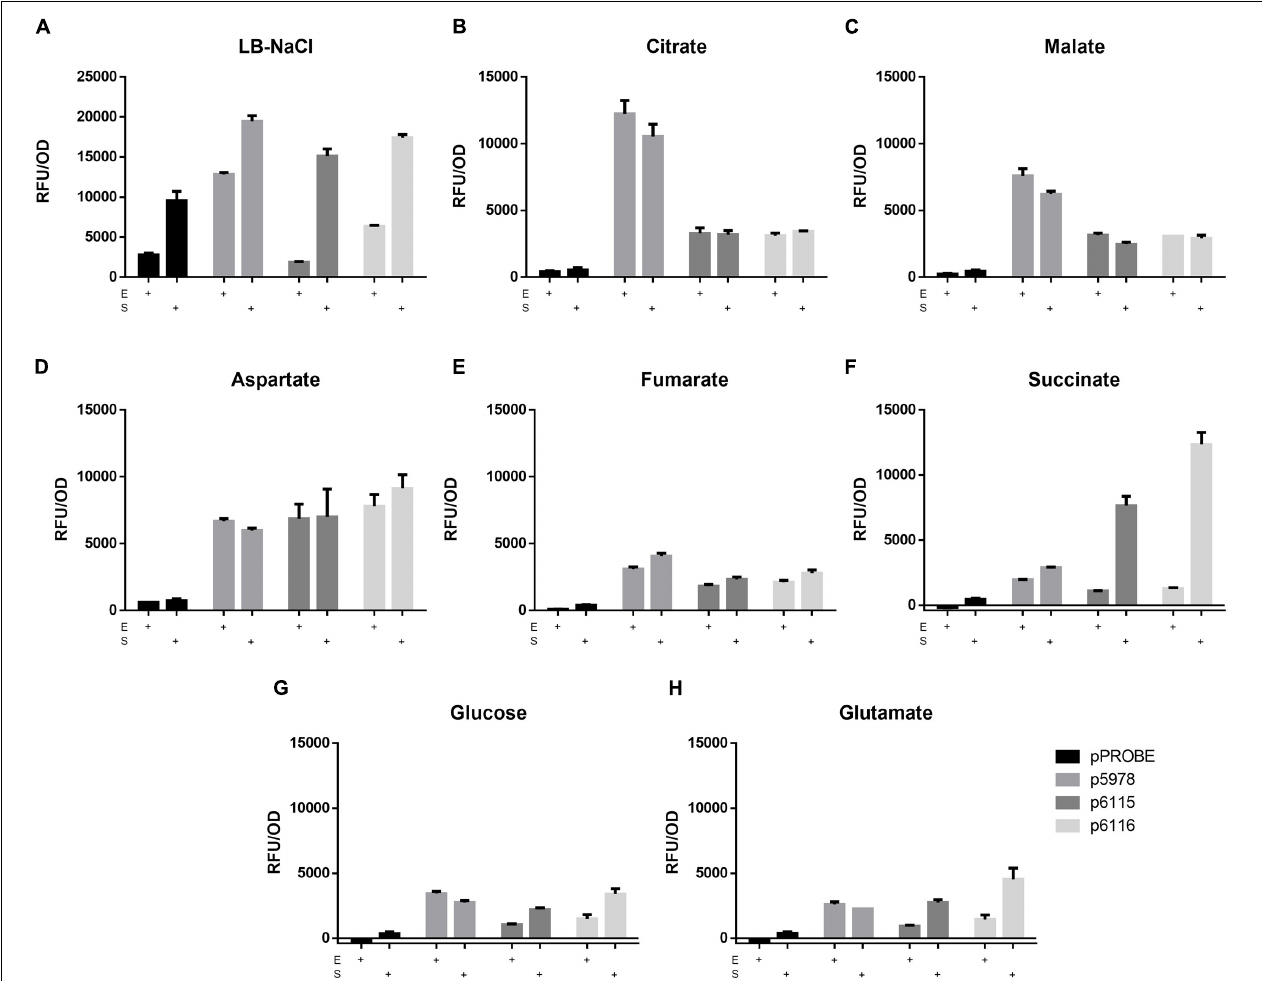
FIGURE 2 | The expression of the promotor fusions (p5978 for T6SS-b and p6115 and p6116 for T6SS-3) in LB-NaCl (A) and minimal media [ (B) citrate, (C) malate, (D) aspartate, (E) fumarate, (F) succinate, (G) glucose, (H) glutamate] with different carbon sources. The expression (GFP) and the growth (OD 600 ) were recorded at the end of the exponential phase (E) and the stationary phase (S). A one-way ANOVA with Tukey’s multiple comparisons test was used to analyze the biological duplicates.